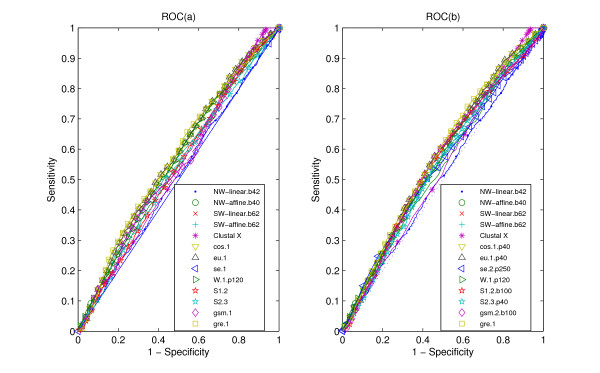
ROC curves for data SP. ROC (a) for our measures, alignment-based measures and other statistical measures, all the statistical measures are based on k-word frequencies of protein sequence, with the parameter values as suffix. ROC (b) for our measures, alignment-based measures and other statistical measures, all the statistical measures are based on k-word frequencies of protein 'sequence space', with the parameter values as suffix. All the abbreviations of (dis)similarity measures are illustrated in the "List of abbreviations" section. A random classifier would generate equal proportions of FP and TP classifications, which corresponds to the ROC diagonal (dashed line).